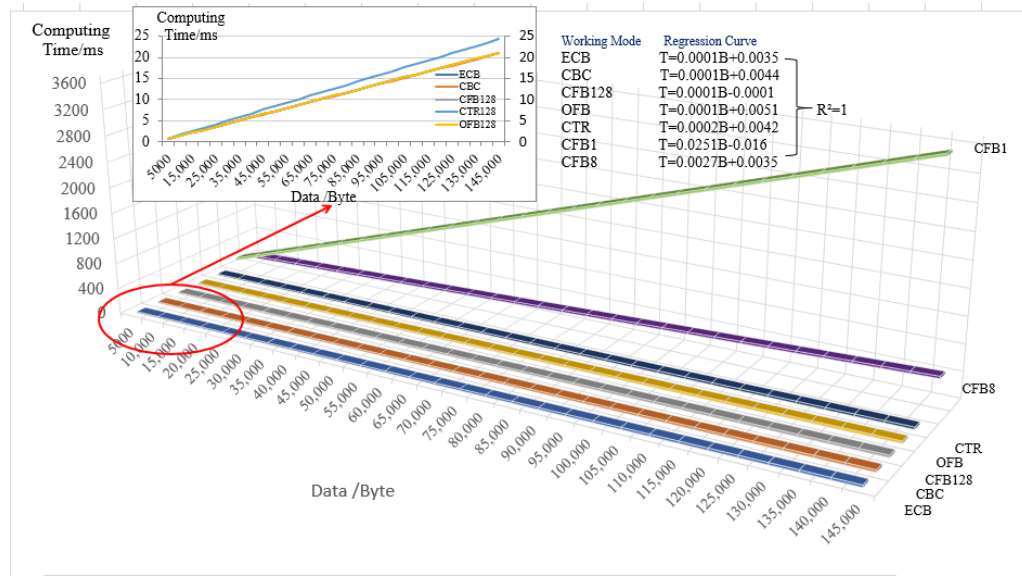
Figure 9. Encrypted plaintext computing cost of 128-bit key in different encrypting modes.